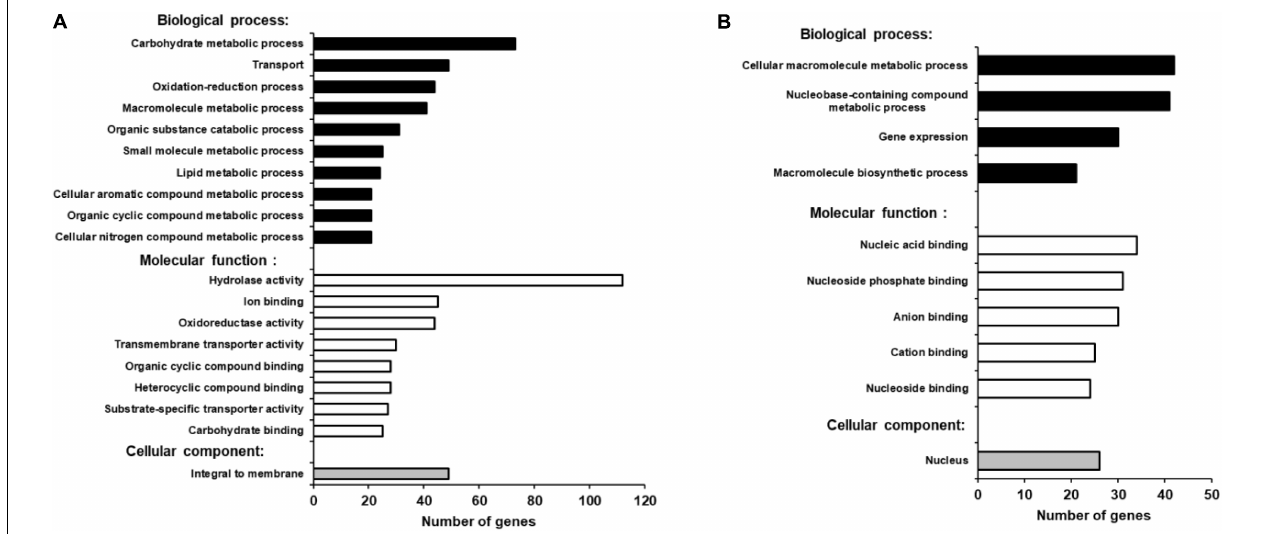
FIGURE 7 | GO enrichment analysis of up-regulated B. cinerea genes. Significantly enriched GO terms classified by biological process, molecular function and cellular component when infecting iqd1-1 (A) or WT plants (B) . Only GO terms that applied to more than 20 differentially expressed genes are shown.